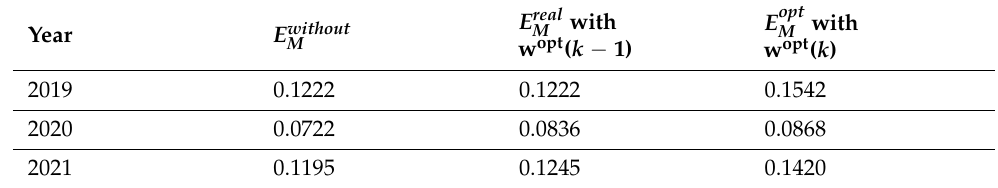
Table 6. Numerical results for the case of one-year historical period.